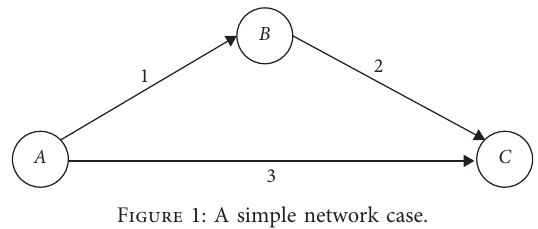
Figure 1: A simple network